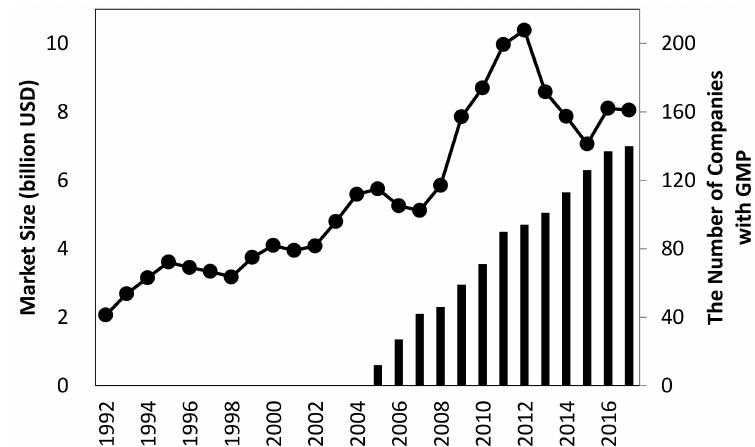
Figure 1. Historical transition of the market size of dietary supplements (the line) and number of good manufacturing practice (GMP)-licensed manufacturers for dietary supplements in Japan (the bars). Data on the market size and the number of companies were obtained from commercially available sources [4] and from GMP certification organizations (Japan Health and Nutrition Food Association—JANFA, and Japanese Institute for Health Food Standards—JIHFS).